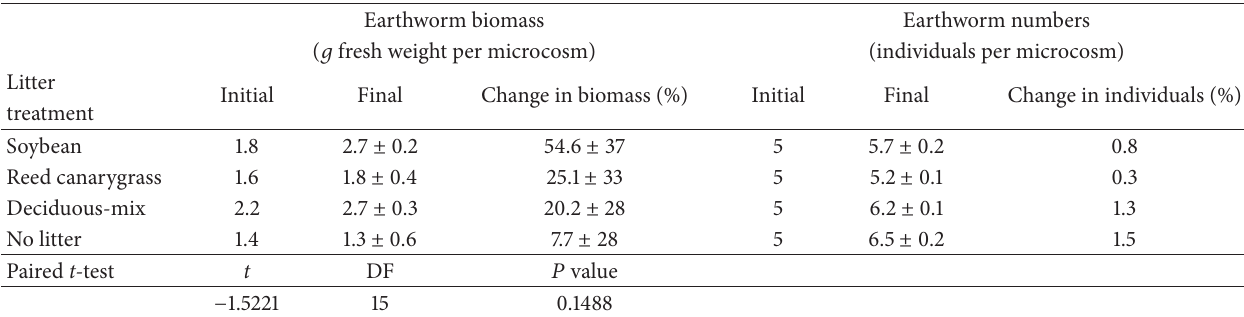
Table 2: Earthworm biomass, number of individuals, and percentage change after 20 wks in soil microcosms with riparian litter. Values are the mean ± standard error ( 𝑛 = 4 ). There was no significant change in biomass or